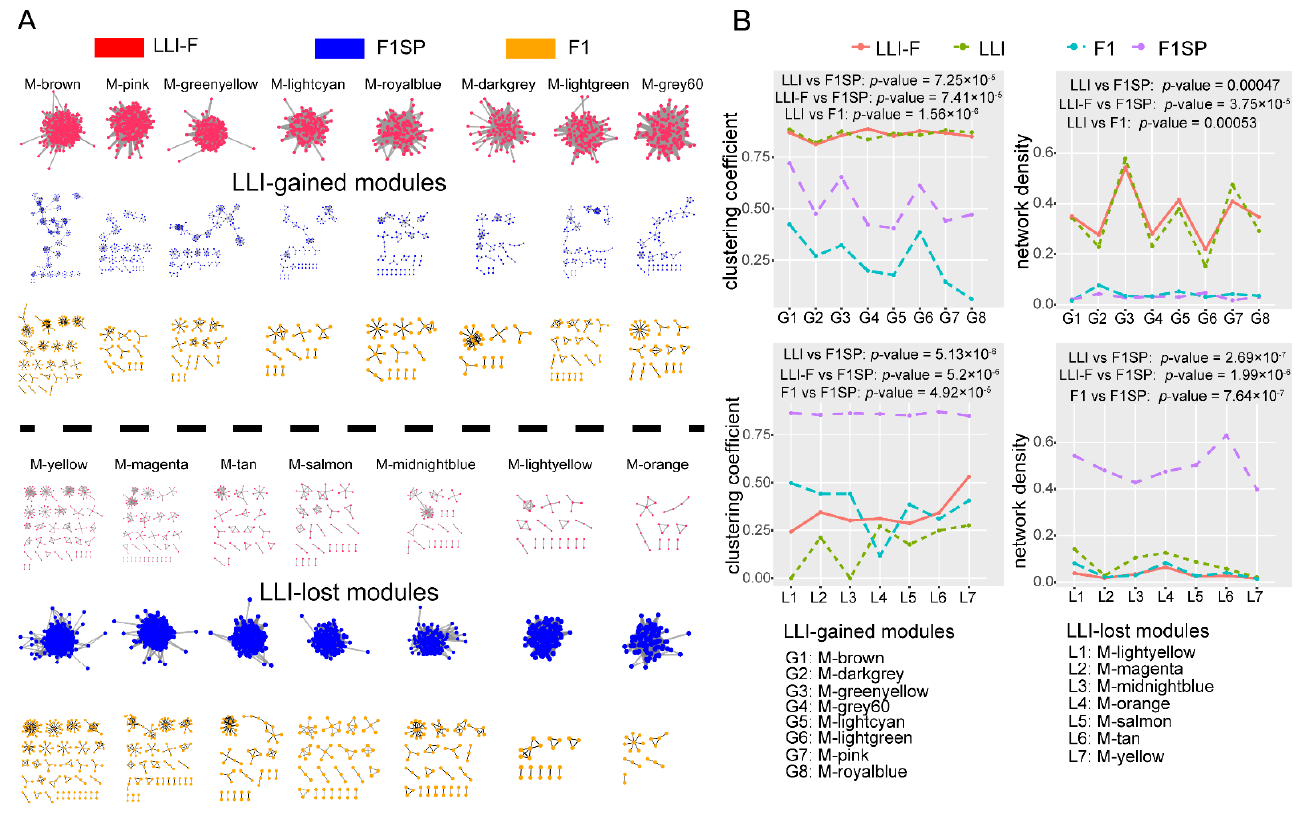
Figure 3. Specific circRNAs co-expression modules were observed gained or lost in long-lived individuals. ( A ) Clustering map of 15 c-CCMs. Upper panel: eight LLI-gained c-CCMs were scattered in F1 and F1SP samples, but clearly clustered in LLI samples; Lower panel: seven LLI-lost c-CCMs exhibited similar discrete clustering distribution in LLI and F1 and were clustered into modules in F1SP. ( B ) Network density and clustering coefficient analysis of LLI-gained and LLI-lost modules in LLI, F1 and F1SP.